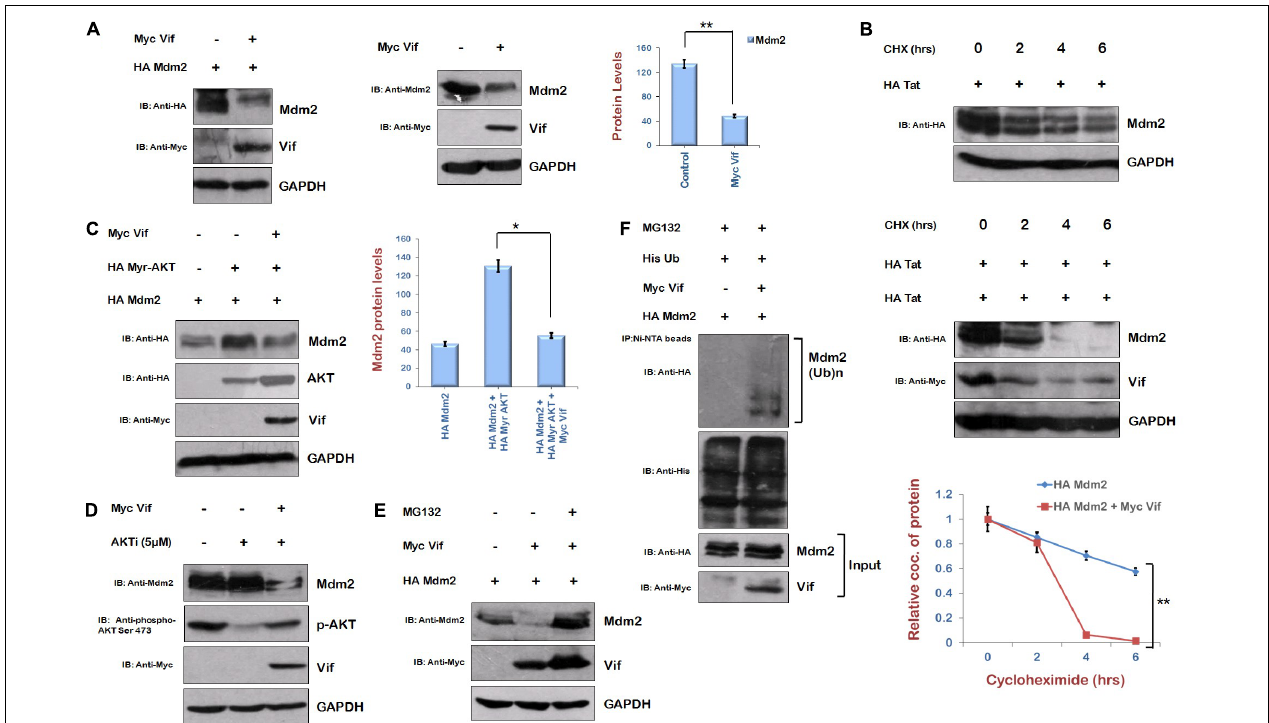
FIGURE 7 | Human immunodeficiency virus type 1 Vif induces proteasomal degradation of Mdm2. (A) HEK-293T cells were cotransfected with HA Mdm2 and Myc Vif expression plasmids for 24 h. Cell lysates were subjected to Western blot analysis using anti-HA, anti-Myc, and anti-GAPDH antibodies. HEK-293T cells were transfected with Myc Vif encoding plasmid for 24 h. Cell lysates were analyzed by Western blotting with anti-Mdm2, anti-Myc, and anti-GAPDH antibodies. (B) HEK-293T cells were transfected with HA Mdm2 and Myc Vif expression plasmids for 24 h as indicated and treated with CHX (100 µ g/mL) for indicated time periods. Cells were lysed, and cell lysates were subjected to SDS-PAGE followed by Western blotting using anti-HA, anti-Myc, and anti-GAPDH antibodies. Densitometry analysis was performed using ImageJ and shown as line graph with error bars. (C) HEK-293T cells were cotransfected with HA Mdm2, HA